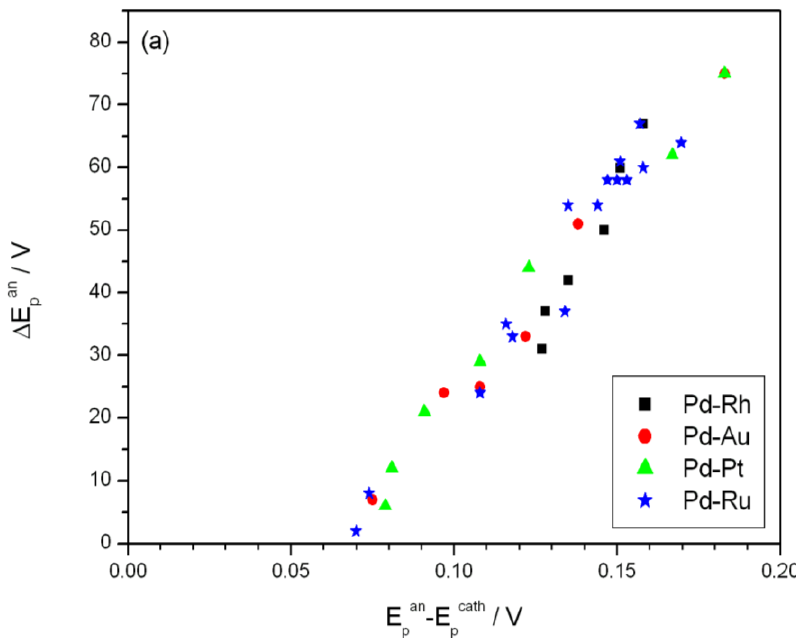
Figure 10. Correlation of the difference between minimum value of the potential of anodic peak 2 just before the phase transition and its final value at low electrosorption potentials (ΔE pan ) with the potential difference of anodic and cathodic peaks 2: ( a ) for various alloys at 298 K; ( b ) at various temperatures for Pd-Pt